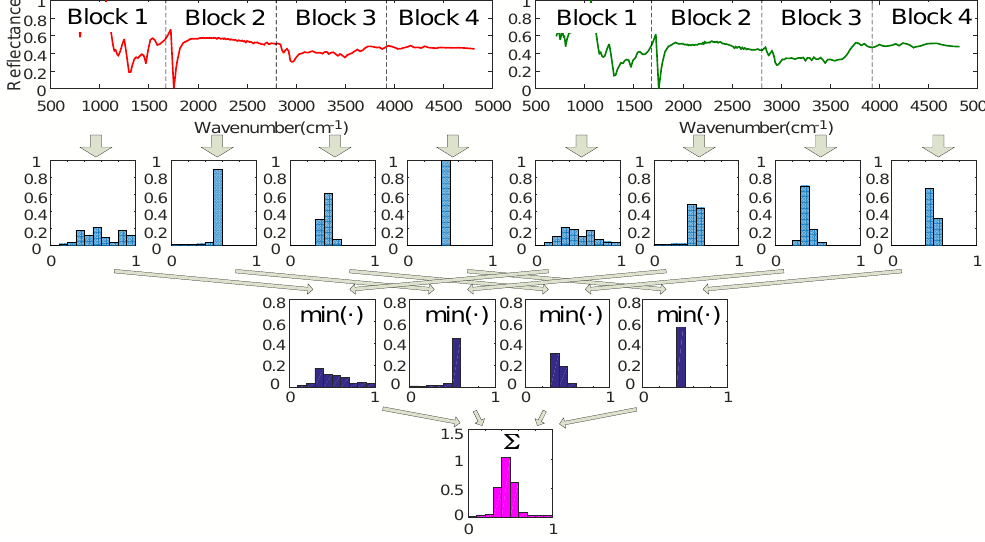
Figure 3. The spatial pyramid at Level 2 ( l = 2 ). The first row: the two spectra (Spectrum A (left), Spectrum B (right)) are divided into four sub-blocks, respectively. The second row (from the left to the right): the histogram of Block 1, Spec. A, the histogram of Block 2, Spec. A, the histogram of Block 3, Spec. A, the histogram of Block 4, Spec. A, the histogram of Block 1, Spec. B, the histogram of Block 2, Spec. B, the histogram of Block 3, Spec. B, the histogram of Block 4, Spec. B. The third row: the histogram intersection kernels. The fourth row: the summation of the histogram intersection kernels referred to in Equation